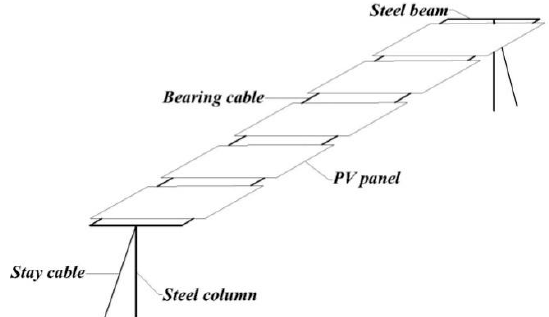
Figure 2. Schematic diagram of fl exible PV system.